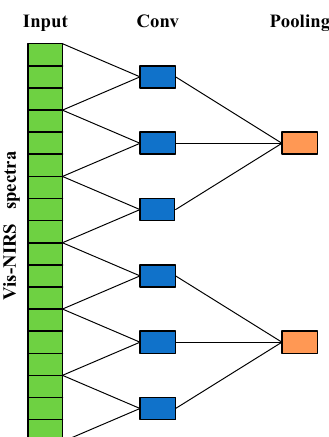
Figure 2. Feature processing of the receptive spectra region by one convolutional layer and one max pooling layer. This is an example of two layers with the convolutional layer having a filter size of three and stride of three and the max pooling layer having a pooling size of three. A green rectangle in the input layer represents one of the input spectral variables, a rectangle in the Conv or Pooling layer represents a neuron. One neuron in the pooling layer covers a receptive field of 9 original spectral variables, respectively.